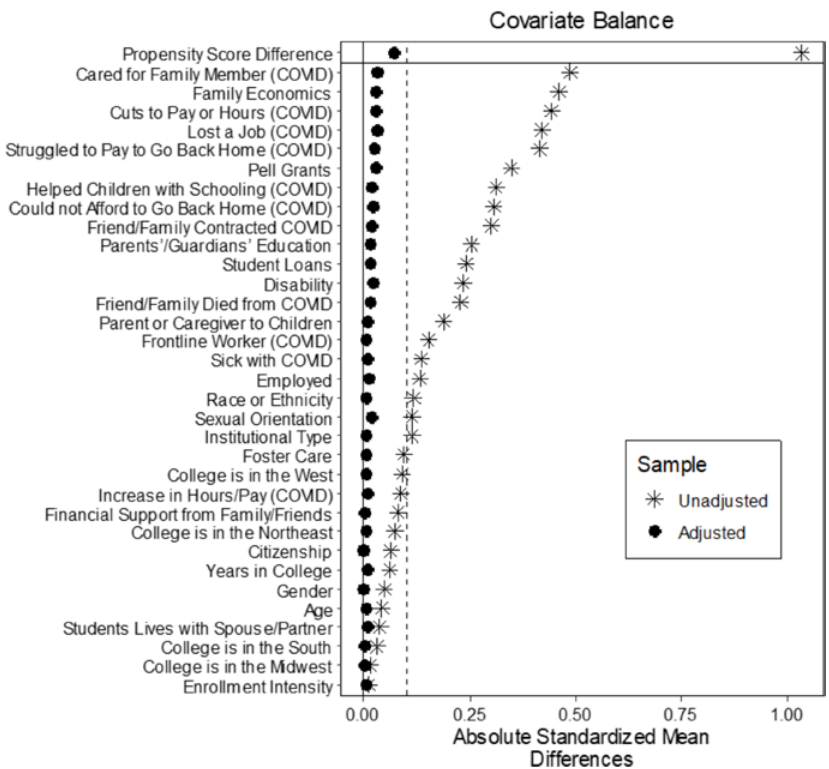
Figure 2. Love Plot of Absolute Standardized Mean Differences for Covariates Before and After